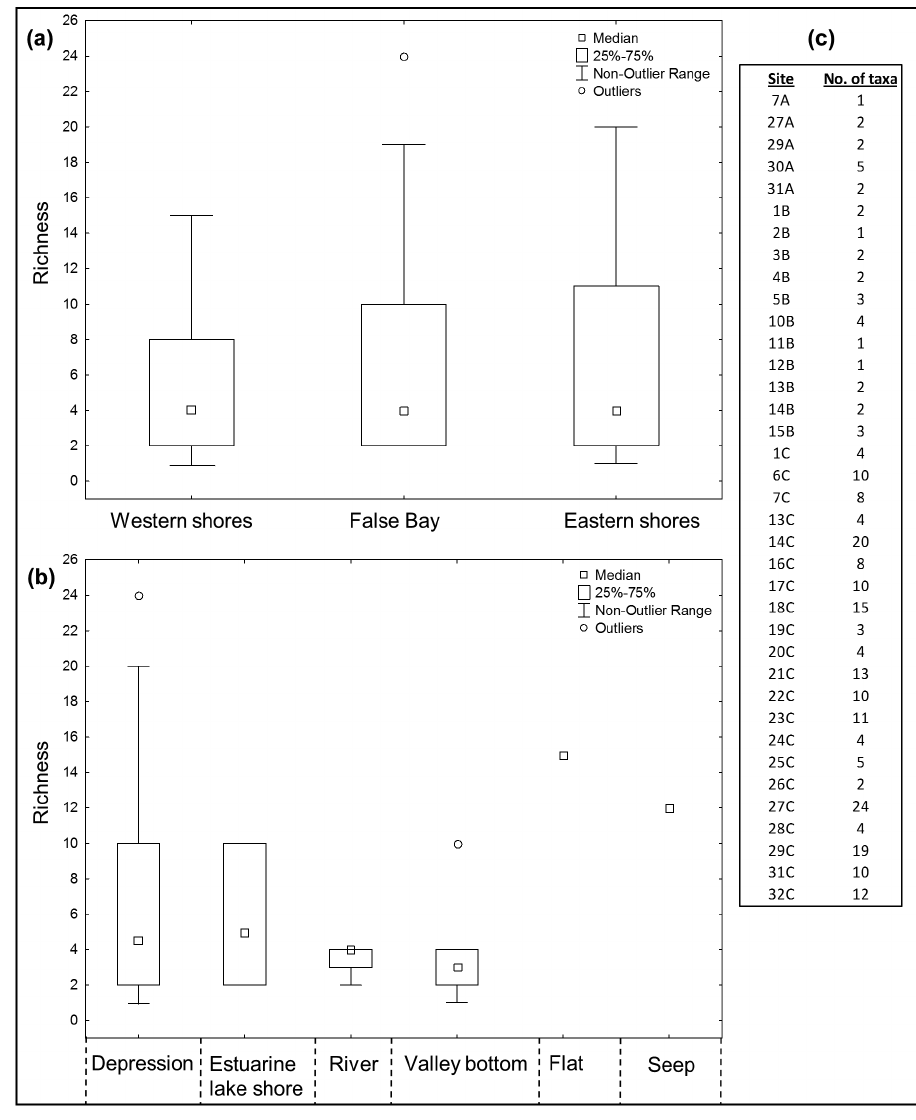
Figure 3. Box-plots comparing the median and spread of species richness (number of polyphagan taxa per site) among (a) regions and (b) waterbody types at St Lucia during the sampling period 2013–2015. The data representing number of taxa per site are also reported (c). Site numbers in (c) are coded as A (first survey–November 2013), B (second survey–July 2014) or C (third survey–January/February 2015). Kruskal-Wallis tests indicated that species richness did not vary significantly among regions (KW-H = 2, 37 0.9006, p = 0.6374) or waterbody types (KW-H = 4.2675, p = 0.5116). 5, 37 False Bay (site 29C with 19 species - Fig. 3c). Polyphagan species richness per site was highly correlated (r = 0.8605, P < 0.001, Fig. 4) with the richness of adephagans sampled concurrently at the same sites (Perissinotto et al.